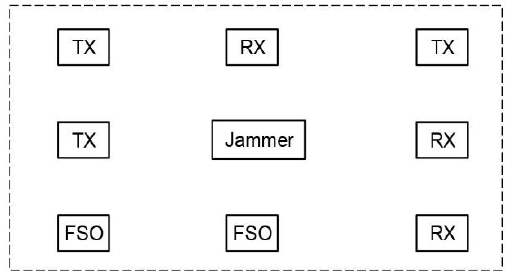
Figure 7. Anti-jamming network: the rectangles labeled with “FSO” in the bottom left and bottom middle show two FSO transmitters (TX: wireless RF transmitter, RX: RF/FSO receiver, FSO: FSO transmitter).